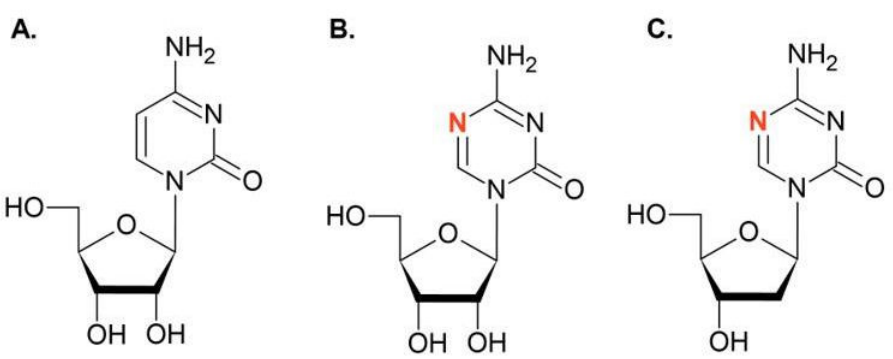
Figure 1. ( A ) Cytidine and its analogs ( B ) 5AC and ( C ) DAC. An additional nitrogen atom (marked in red) is responsible for the inhibitory activity of these molecules toward